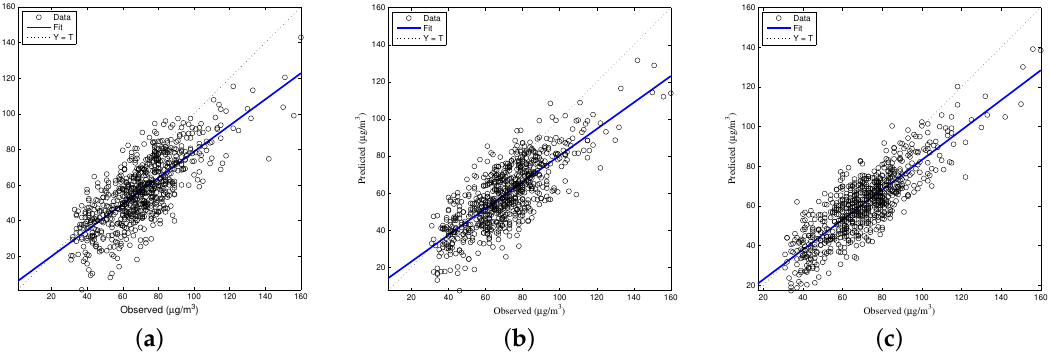
Figure 3. Comparison of prediction results among multiple linear regression (MLR), feedforward neural network based on back propagation (FFANN-BP), and extreme learning machine (ELM). NO 2 predictions ( a ) MLR; ( b ) FFANN-BP; ( c ) ELM.